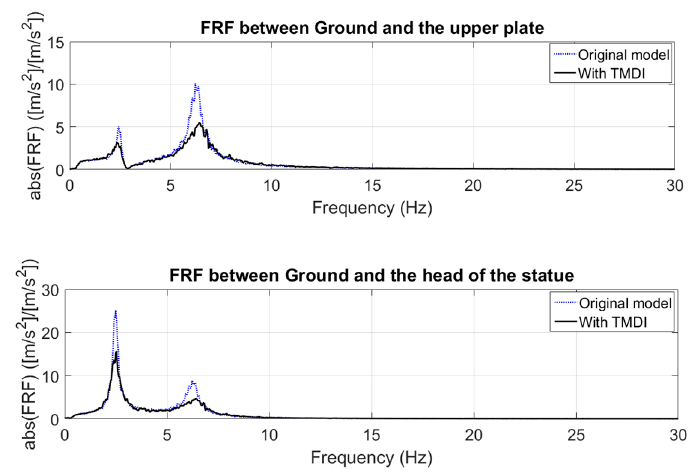
Figure 12. FRFs obtained from the multi-degree-of-freedom (MDOF) model without and with TMDIs for case 1.